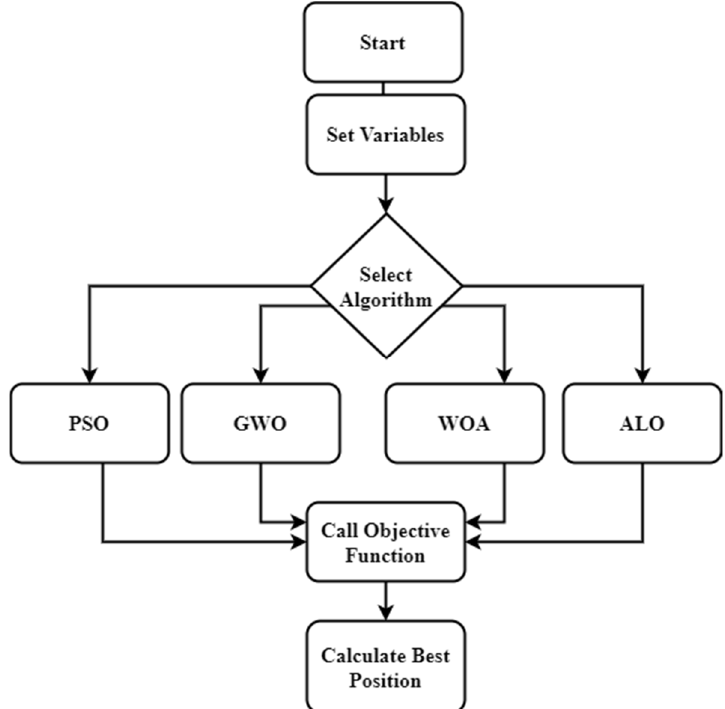
Figure 2. Flowchart of the toolbox.